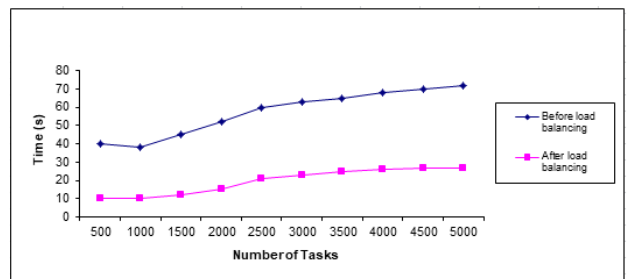
Figure 14. Degree of imbalance.